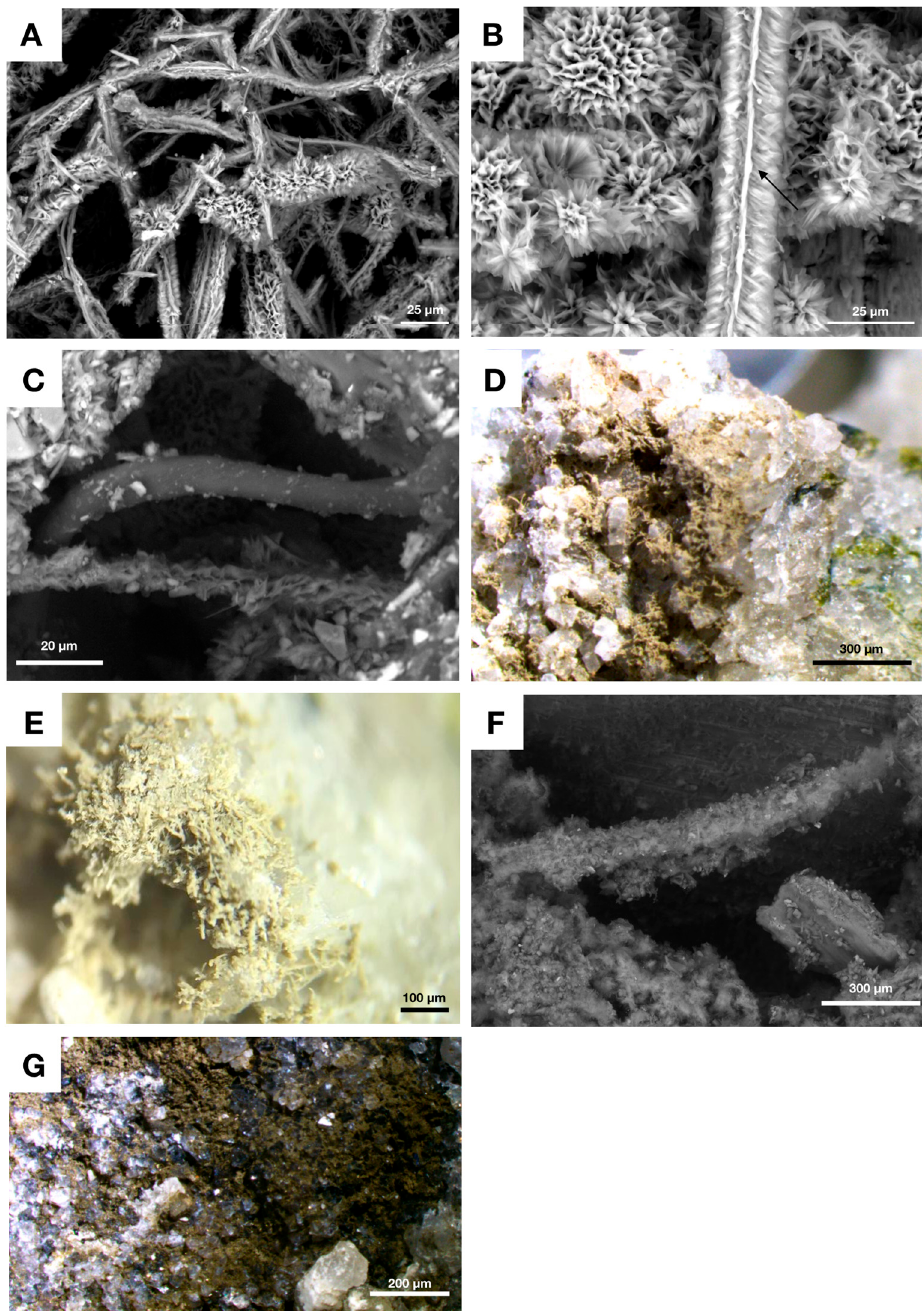
Figure 2. Scanning electron (A–C, F, G) and stereo (D, E) micrographs of fungal fossils from fractured granitic rock, Laxemar drill-cores, Sweden. The fossils are preserved mainly by clay mineralization but also as carbonaceous filaments. ( A ) Clay mineralized hyphae with a central strand. Scale bar equals 25 μ m. ( B ) Close-up of clay mineralized hyphae with a central strand (arrow). Scale bar equals 25 μ m. ( C ) Part clay-part carbonaceous fungal hyphae preserved within a hollow fracture. Scale bar equals 20 μ m. ( D ) Sample of flight fungal biofilm from Laxemar run by XRD and Mössbauer spectroscopy for this review. Calcite surround the biofilm. Scale bar equals 300 μ m. ( E ) Close-up of light fungal clay mineralized hyphae run by XRD and Mössbauer spectroscopy for this review. Scale bar equals 100 μ m. ( F ) Poorly preserved fungal hyphae with uneven clay encrustation. Scale bar equals 300 μ m. ( G ) XRD and Mössbauer spectroscopy sample showing a dark clay phase assumed to represent altered fungal biofilm from Laxemar. Scale bar equals 200 μ m.